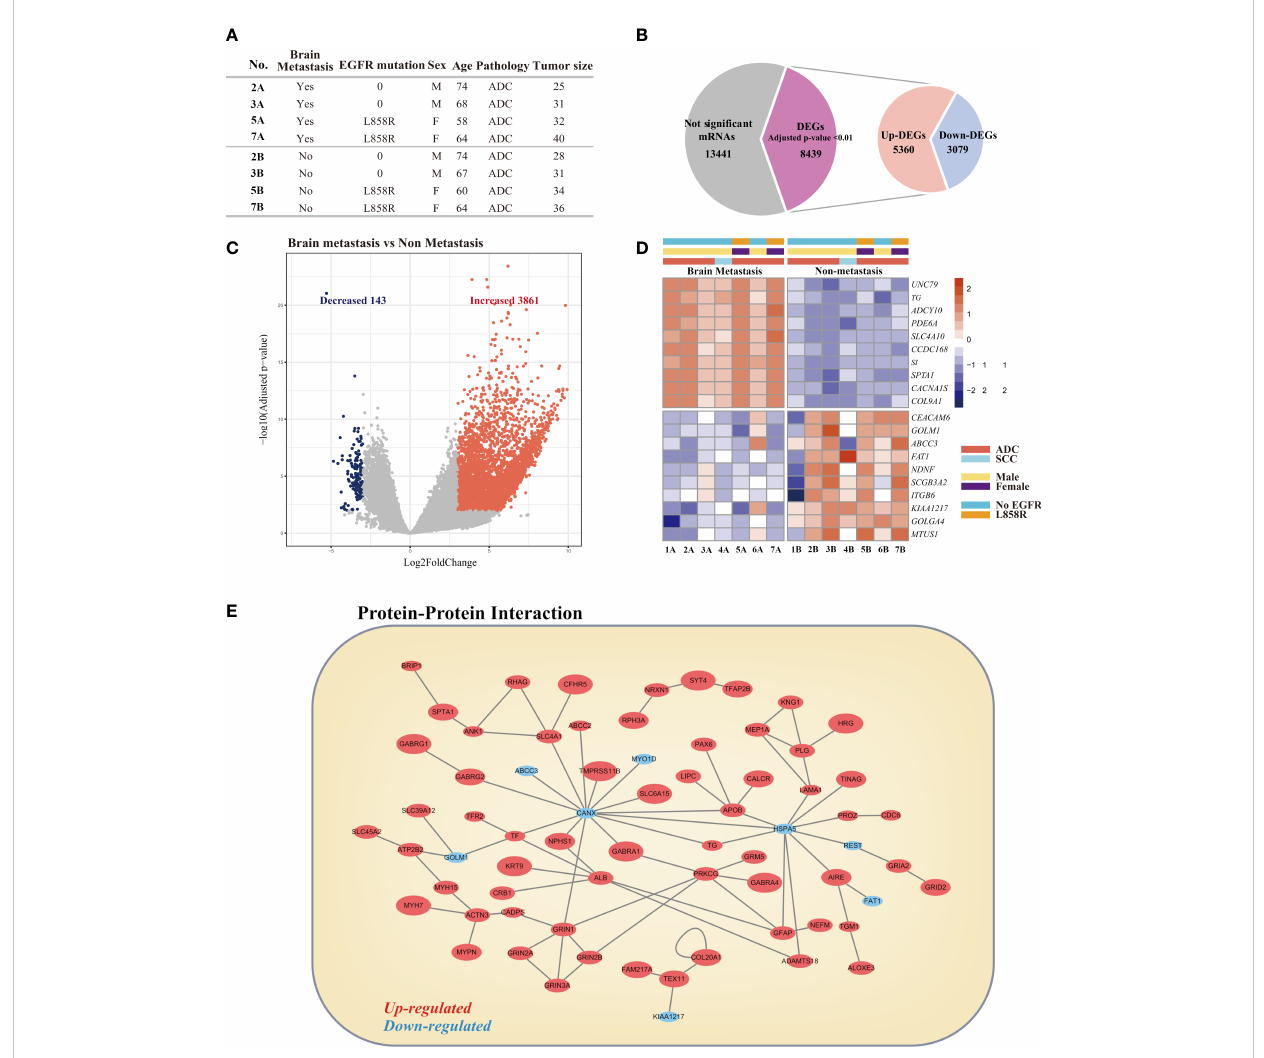
FIGURE 4 Comparative analysis of differentially expressed genes (DEGs) in lung cancer with brain metastasis and lung cancer without brain metastasis. (A) Clinical characteristics of patients selected for analysis. (B) Venn diagrams for the DEGs in the two comparison groups. Signi fi cance was de fi ned by adjusted p-value <0.01. (C) Volcano plot of the DEGs. (D) Heatmap visualization of the top 10 most upregulated and top 10 most downregulated DEGs. (E) Protein – protein network of